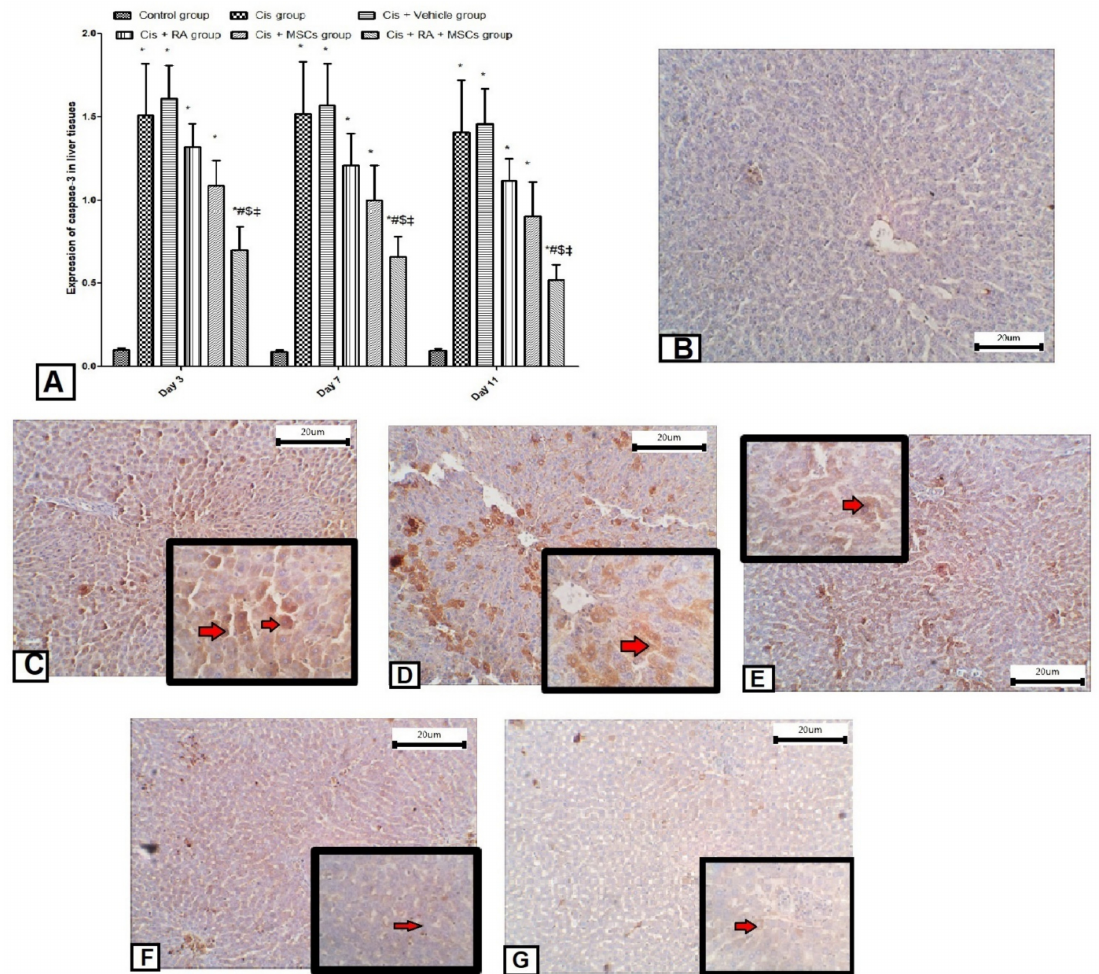
Figure 6. Immunohistopathological examination for the expression of caspase-3 in liver spec- imens. The score of caspase-3 expression in liver at different time intervals (3 days, 7 days and 11 days) showed significant rise in its expression in Cis group with significant attenuation Cis + RA + BM-MSCs group ( A ). Microscopic pictures of immunostained hepatic sections stained with caspase-3 from rats groups sacrificed at 11 days showing negative staining in control group (( B ) 100 × ), increased positive brown expression of caspase-3 (red arrows) in hepatocytes in Cis group group (( C ) 100 × with high power 400 × side box), Cis + vehicle group (( D ) 100 × with high power 400 × side box), Cis + RA group (( E ) 100 × with high power 400 × side box) and weak expression in BM-MSCs group (( F ) 100 × with high power 400 × side box), and Cis + BM-MSCs + RA group (( G ) 100 × with high power 400 × side box). * Significant vs. Control group, # significant vs. Cis group, $ significant vs. Cis + MSCs group and ‡ significant vs. RA